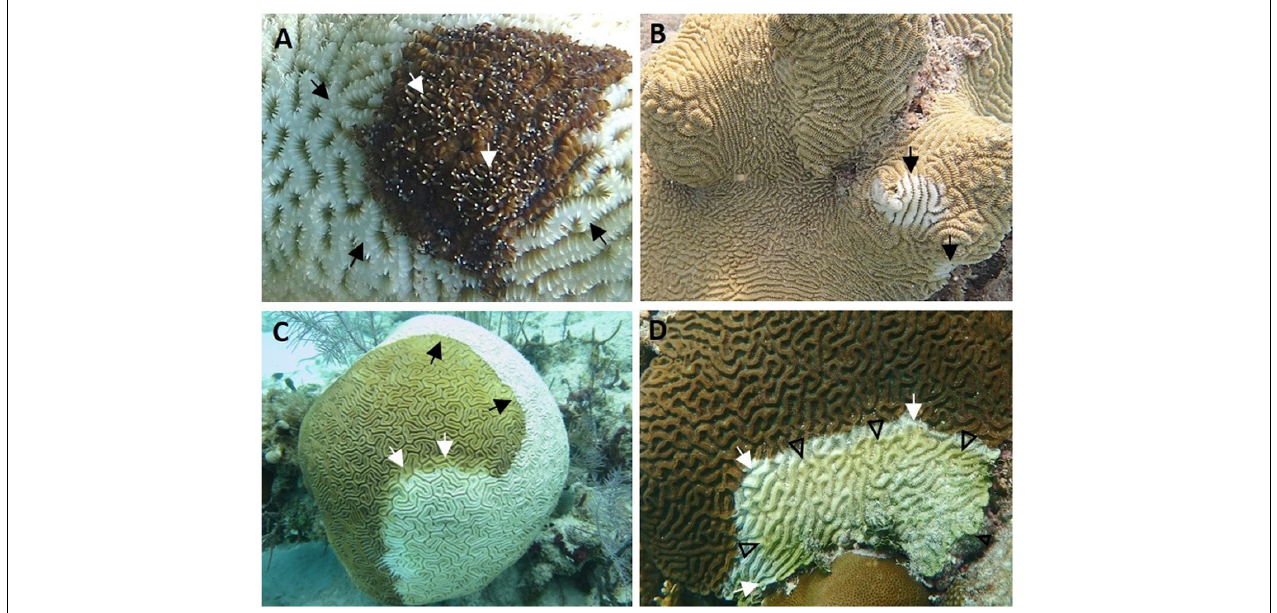
FIGURE 2 | Gross acute to subacute lesions of stony coral tissue loss disease. (A) Dendrogyra cylindrus with acute tissue loss (black arrows). Note distinct area of bare white skeleton surrounding intact tissue, with tentacles extended (white arrows) from some polyps. (B) Meandrina meandrites with multifocal acute tissue loss. Note distinct areas of bare white skeleton on edge and center of colony (arrows). (C) Diploria labyrinthiformis with diffuse acute tissue loss. Note distinct area of bare white skeleton apposed to intact tissue (black arrows) with intermittent bands of pallor at lesion edge (white arrows). (D) Colpophyllia natans with focal subacute tissue loss. Note distinct domed area of bare white skeleton apposed to intact tissue (white arrows) arising from colony edge (bottom) followed by an area of exposed bare skeleton covered in turf algae and debris (arrowheads). (A) Stag Party East, April 2018; (B) Looe Key, April 2018; (C) Grecian Rocks, July 2016; (D) Dustan Rocks, April 2018. Photos: (A) Karen Neely; (B) Tiffany Boisvert; (C) Vanessa Brinkhuis; (D) Brian Reckenbeil.